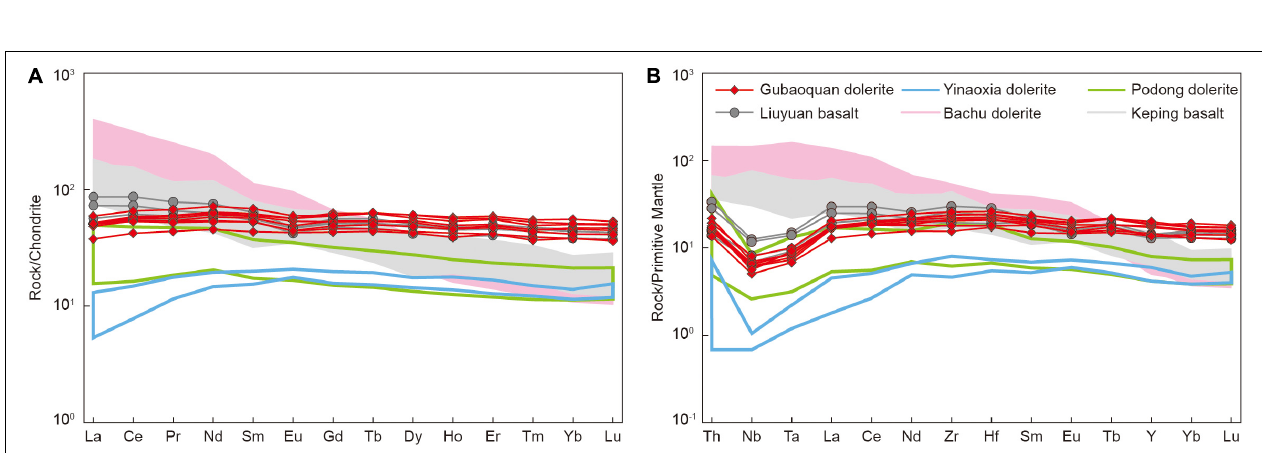
FIGURE 6 | (A) Chondrite-normalized REE patterns and (B) primitive mantle-normalized immobile element patterns for the Gubaoquan dolerite dykes. Normalizing values from Sun and McDonough (1989). Data sources: Yinaoxia dkes (Zhang et al., 2015), Podong dykes (Xue et al., 2016), Tarim Bachu dolerite dikes (Yu, 2009), and Tarim Keping basalt (Jiang et al.,